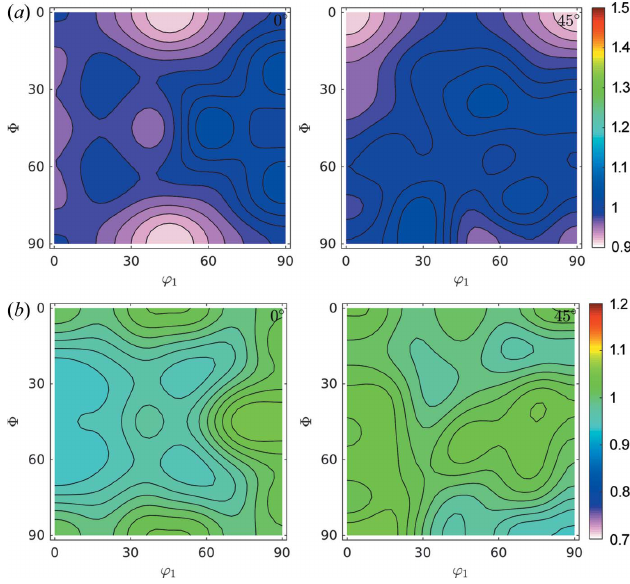
Figure 15 GDFs for ( a ) domain size and ( b ) dislocation density at ’ 2 = 0 (cid:6) and ’ 2 = 45 (cid:6) . Heat-treated sample, 5 s at 730 (cid:6) C.